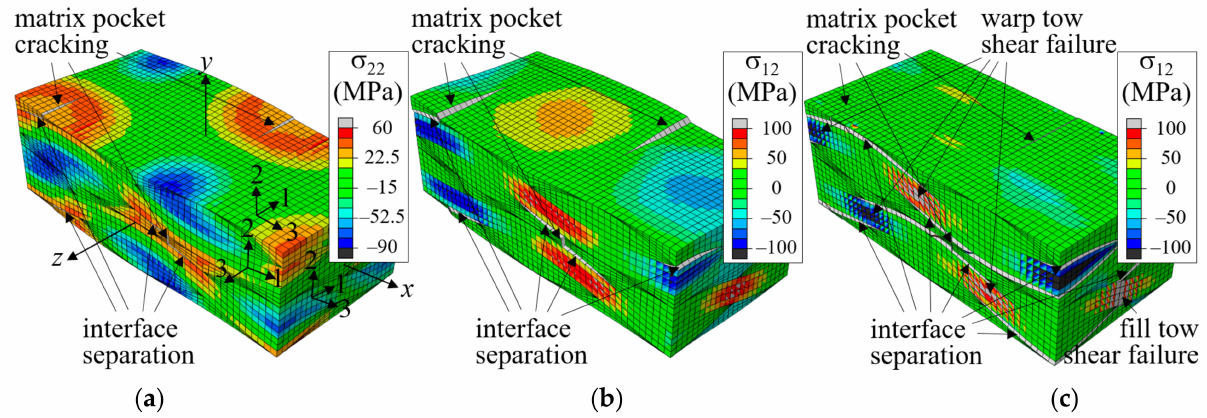
Figure 13. Fracture development process for two-ply shifted unit cell: ( a ) σ 22 at ˆ ε xx = 0.00969; ( b ) σ 12 at ˆ ε xx = 0.0136; and ( c ) σ 12 at ˆ ε xx = 0.0138 (Deformation scale factors are 5, 3, and 1 for ( a – c ),